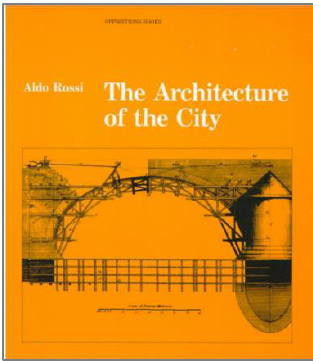
Figure 13 The Architecture of the City (Rossi, A.,